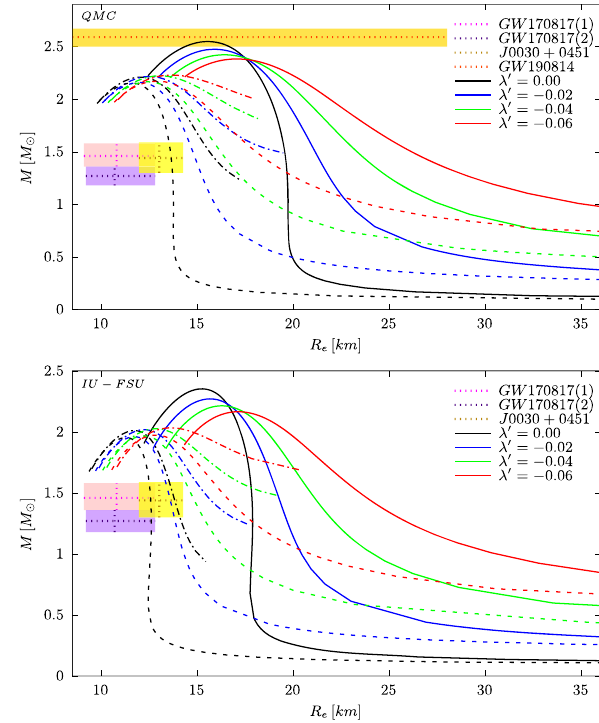
Fig. 2 The mass–radius relation for sequences of non-rotating stars (dashed curves), stars rotating at 716 Hz (dash-dot curves) and for stars rotating at the mass-shedding limit (solid line curves). The curves for λ (cid:6) = 0 correspond to the GR